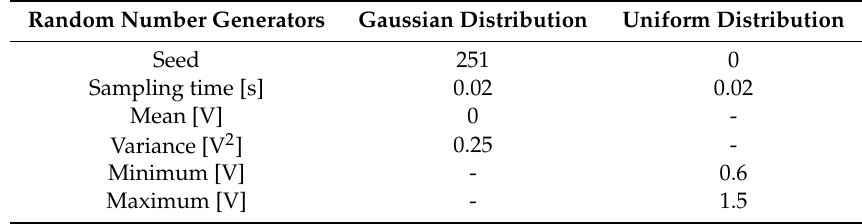
Table 2. Identified system parameters.